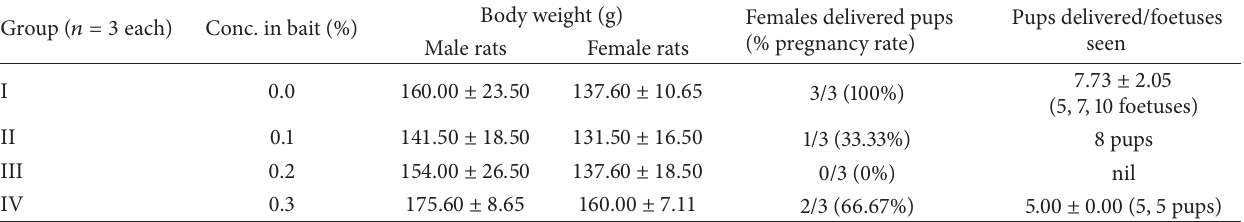
Table 2: Effect of triptolide treatment on reproductive performance of male R. rattus paired with untreated cyclic female rats. Group ( 𝑛 = 3 each)